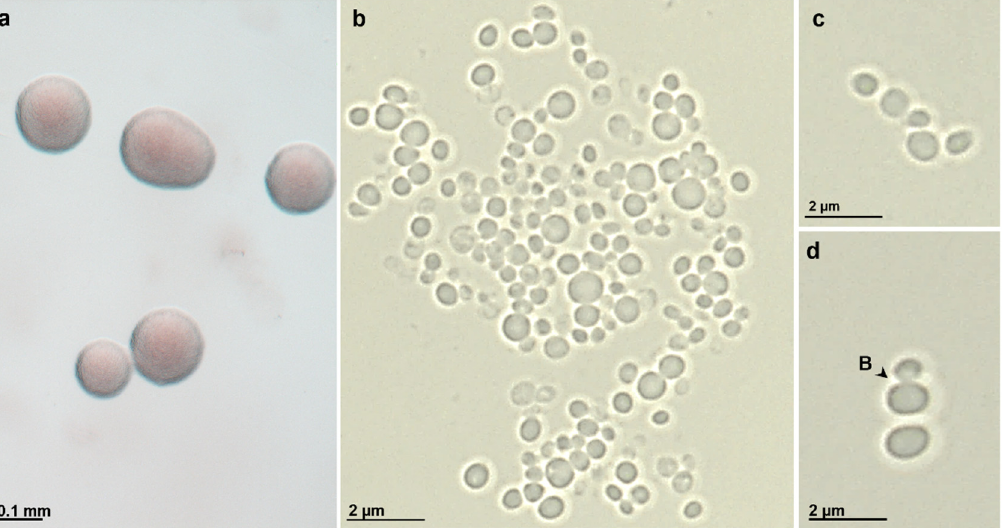
Figure 4. Phenotypic characterization of strain ICT_E10.1 T while in exponential phase. Photographies of strain ICT_E10.1 T in modified M14 medium ( a ) show its pink coloration and in bright field microscopy images ( b – d ) cells appear spherical to ovoid in shape and cluster in aggregates ( b ) or small chains ( c ). Budding is the division mode ( d ).